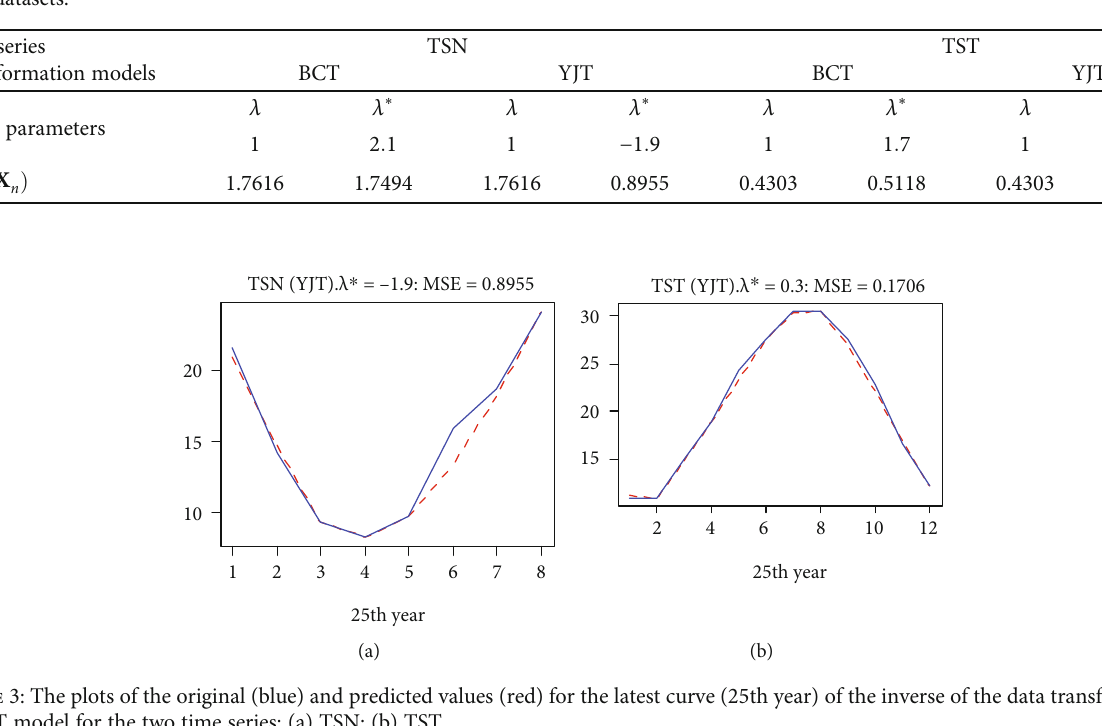
n for the two time